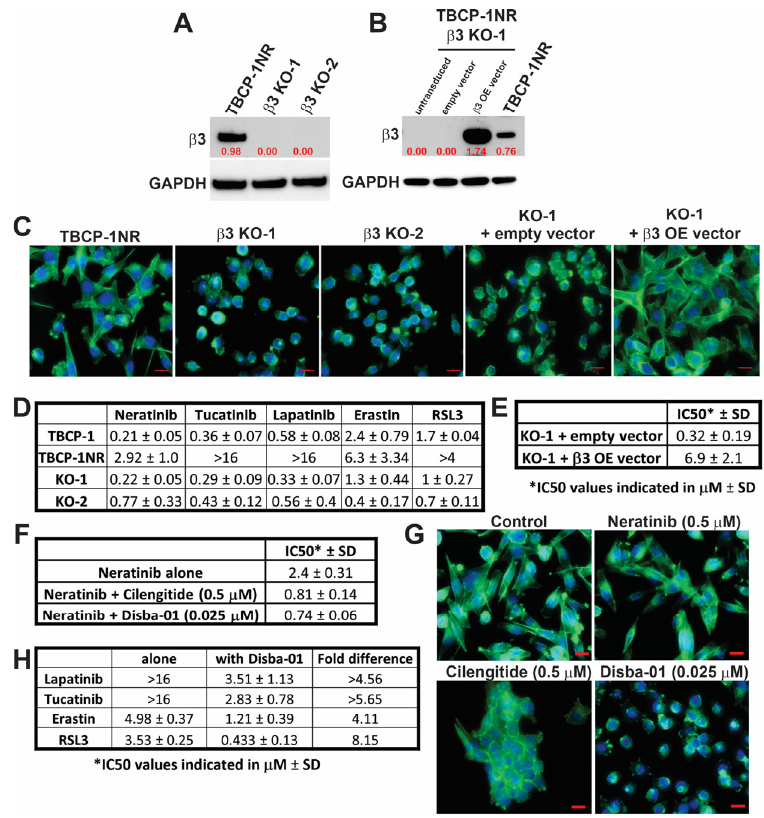
Figure 3 . Integrin β 3 functionally regulates morphology and TKI response in HER2-positive cells in vitro. ( A ) Genetic KO of integrin β 3 was confirmed in the indicated TBCP-1NR clones (KO-1 and KO-2) by Western blot analysis of whole-cell lysates and GAPDH was used as loading control. The intensity ratio of each band relative to GAPDH is indicated in red. ( B ) Overexpression of integrin β 3 in TBCP-1NR β 3 KO-1 cells relative to untransduced or empty vector transduced cells was validated by Western blot analysis of whole cell lysates and GAPDH was used as loading control. The intensity ratio of each band relative to GAPDH is indicated in red. ( C ) Morphological changes in integrin β 3 control, KO or OE cells were visualised by F-actin staining using A488-conjugated phalloidin. Red (Scale bar) = 50 µ m. Blue (DAPI) = nuclei and Green (A488-phalloidin) = F-actin. ( D ) The sensitivity of integrin β 3 KO clones to TKIs (neratinib, lapatinib, and tucatinib) and ferroptosis inducers (Erastin and RSL3) was determined using a 3-day SRB assay. The data show mean IC50 ± SD from three independent experiments ( n = 3). ( E ) Sensitivity of empty vector, or integrin β 3 OE vector transduced β 3 KO-1 cells to neratinib was determined in a 3-day SRB assay. The data show mean IC50 ± SD from three independent experiments ( n = 3). ( F ) The potency of α v β 3 integrin inhibitors (Cilengitide or Disba-01) was assessed in combination with neratinib in a 3-day SRB assay. The data show mean IC50 ± SD from three independent experiments ( n = 3). ( G ) Morphological changes following neratinib (0.5 µ M), Cilengitide (0.5 µ M) or Disba-01 (0.025 µ M) treatment were visualised by F-actin staining using A488-conjugated phalloidin. Red (Scale bar) = 50 µ m. Blue (DAPI) = nuclei and Green (A488-phalloidin) = F-actin. ( H ) The potency of Disba-01 (0.025 µ M) in combination with lapatinib, tucatinib, Erastin or RSL3 was assessed using a 3-day SRB assay. The data show mean IC50 ± SD from three independent experiments ( n = 3). The uncropped blots are shown in Supplementary File